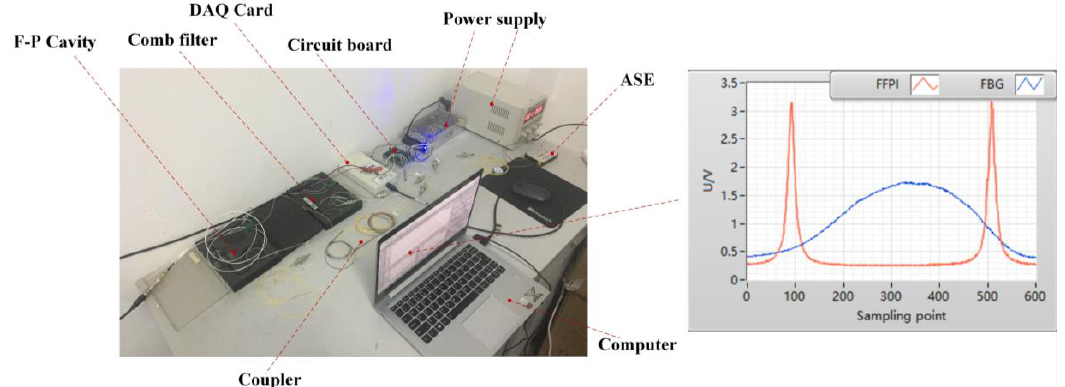
Figure 14. Structure of the measurement system.